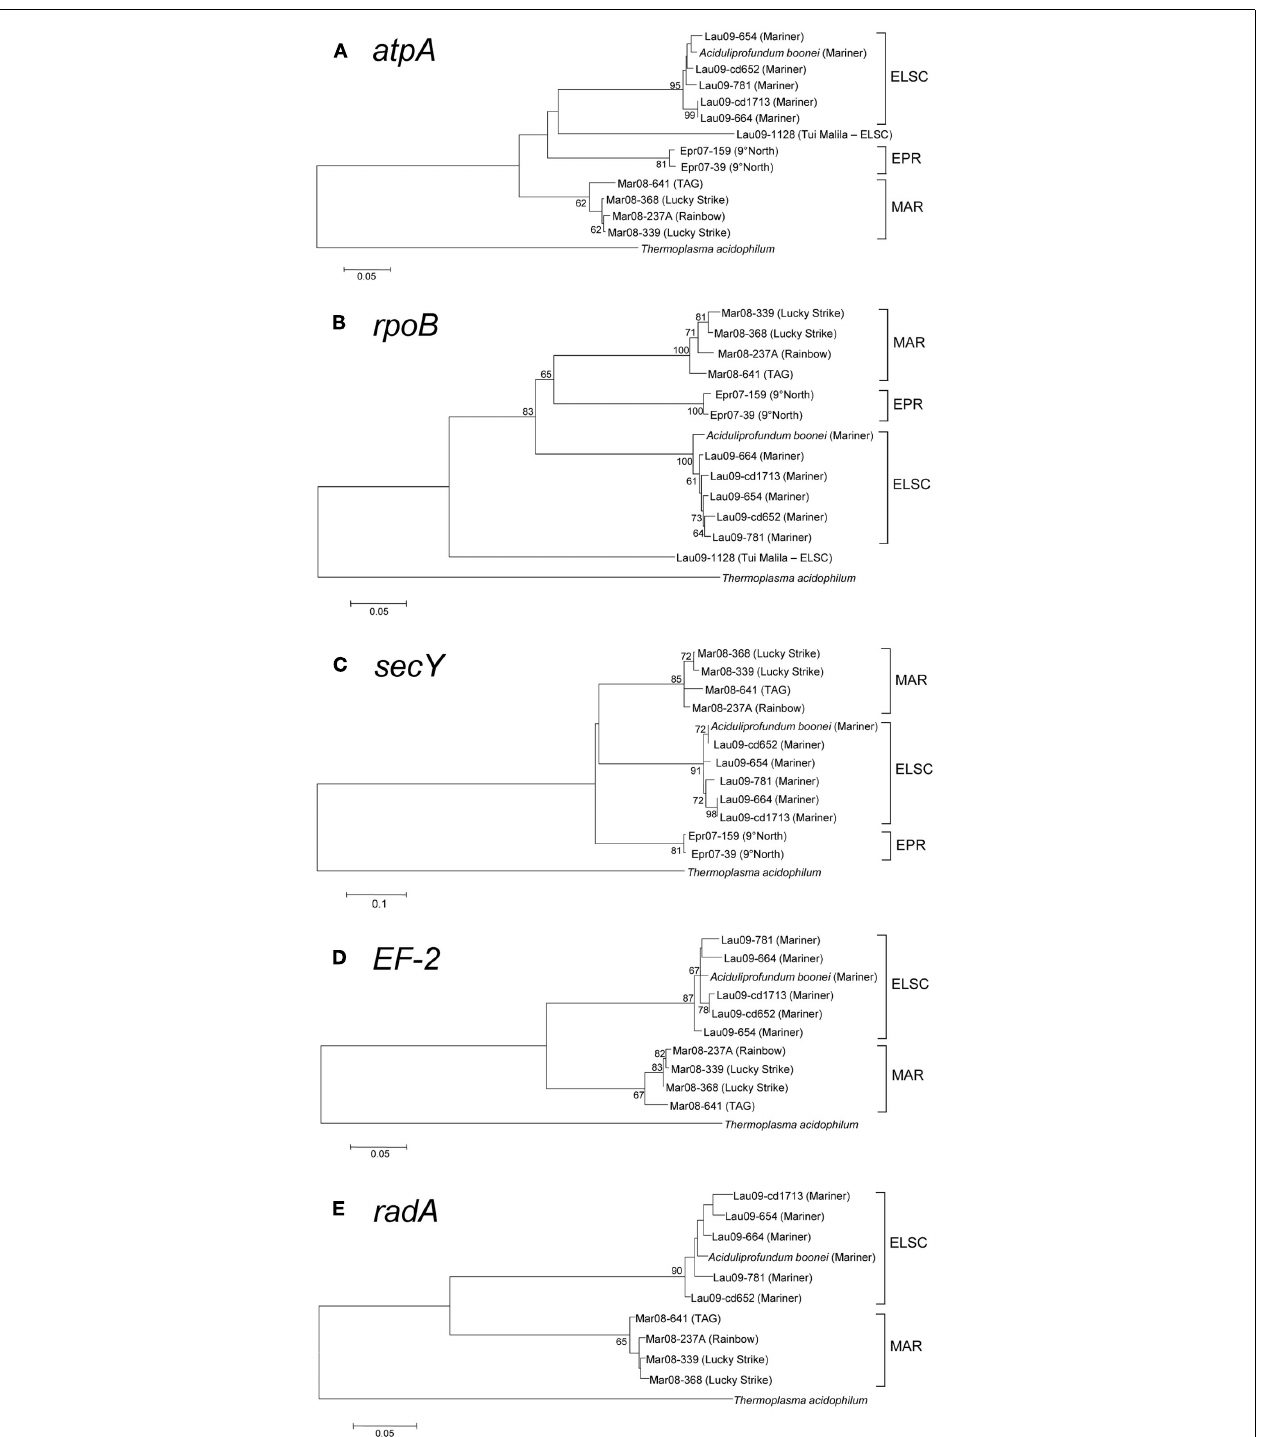
FIGURE 5 | Maximum-likelihood bootstrapped phylogenetic trees of various protein-coding genes from DHVE2 isolates. (A) atpA consensus tree constructed using the Kimura 2-parameter model (Kimura, 1980) taking into account a gamma distribution for the substitution rate. (B) rpoB consensus tree constructed using theTamura-Nei model (Tamura and Nei, 1993). (C) secY consensus tree generated usingTamura 3-parameter model